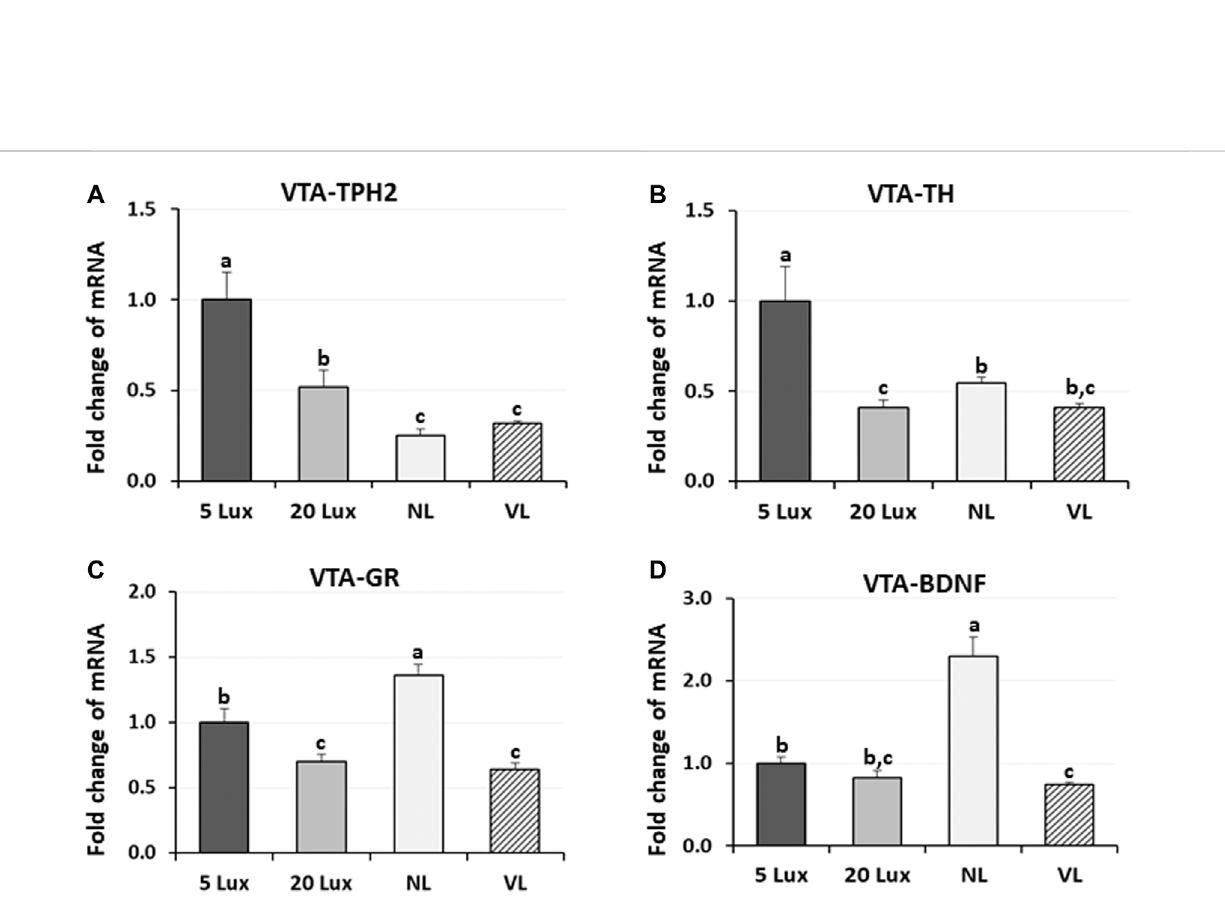
FIGURE 7 Regulation of VTA welfare related marker genes. Expression changes of (A) TPH2, (B) tyrosine hydroxylase (TH, the rate-limiting enzyme of dopamine biosynthesis), (C) glucocorticoid receptor (GR), and (D) brain-derived neurotropic factor (BDNF) mRNA in the ventral tegmental area (VTA) of birdsat42 daysofageweremeasuredinfourdifferentlightingprogramhouses.Lightintensityprogramswerechangedatday7 – 5,20,480lx(NLhouse), 2 – 5 lx/40 lx (VL house). Brains of male bird were sampled on day 42 ( n = 12/section, 4 sections/house). VTA of the brainstem from each bird was dissected as described in Figure 5. Total RNA was extracted and used for RT-qPCR. Data were set as the relative fold changes of expression levels using the ΔΔ Ct method with GAPDH and β -actin as internal controls. Data (mean ± SEM) were expressed from a value set for 1.0 for 5 lx birds for each gene. Different lower-case letters above the bars denote signi fi cant differences ( p < 0.05) among groups, where a > b > c and b,c is not different from b or